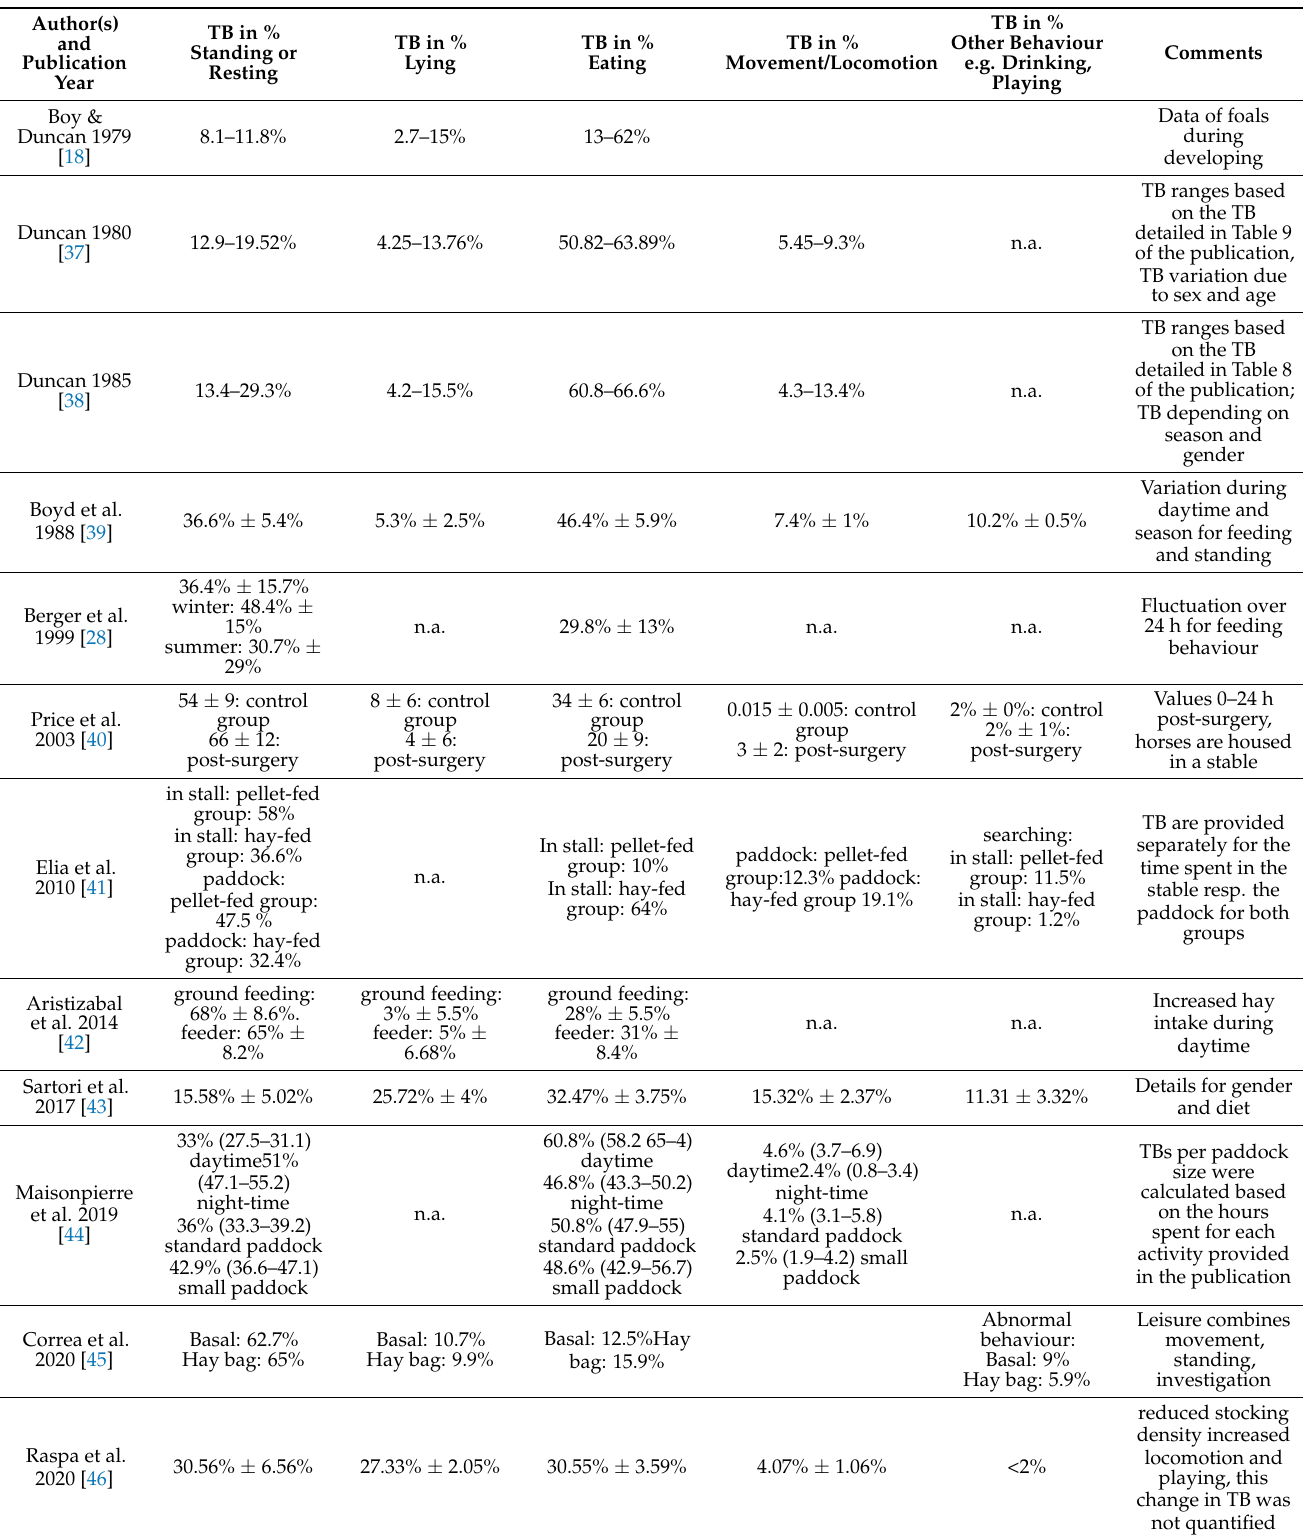
Table 3. Time budgets for standing/resting, lying, eating, movement/locomotion and other behaviors determined in the 12 studies included in this review, provided as range, or mean ± standard